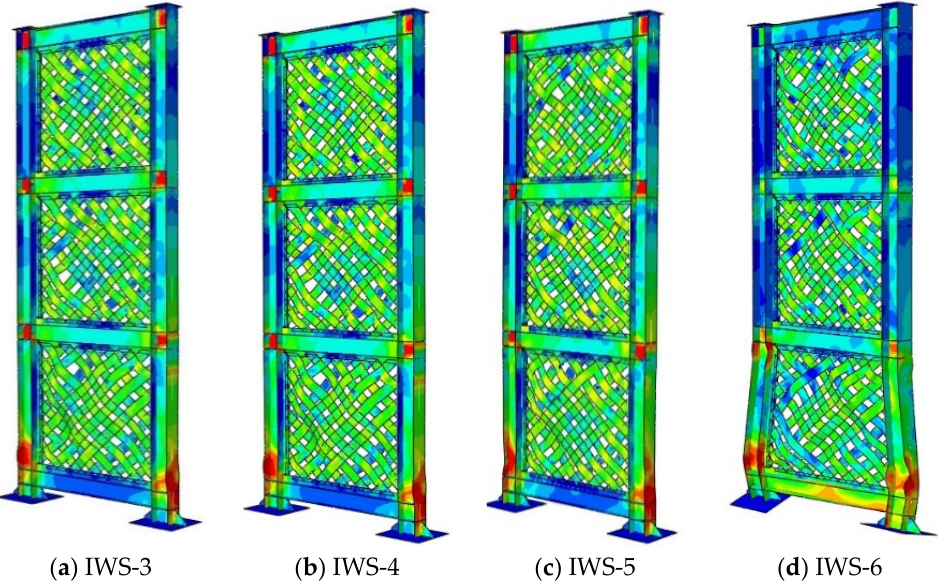
Figure 18 . Parametric FE models: Effect of the steel yield stress and infill-strip thickness. Figure 18. Parametric FE models: Effect of the steel yield stress and infill-strip